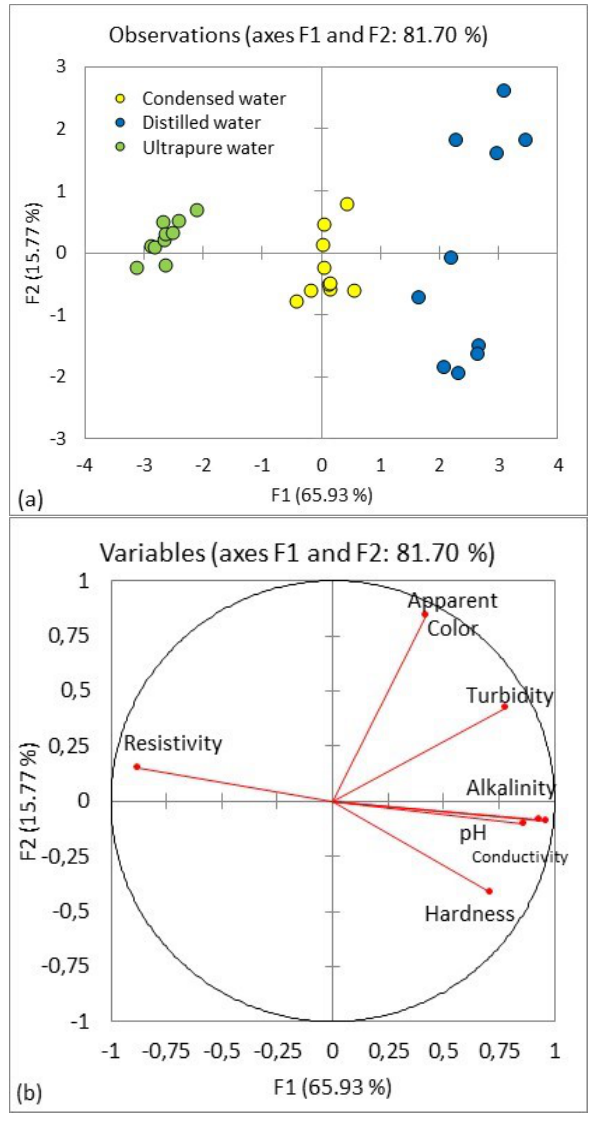
Figure 11: Principal Component Analysis to the group condensed, distilled and ultrapure water. Samples whereupon (a) set of data represented by each group and (b) orientation of the variables con- sidered.